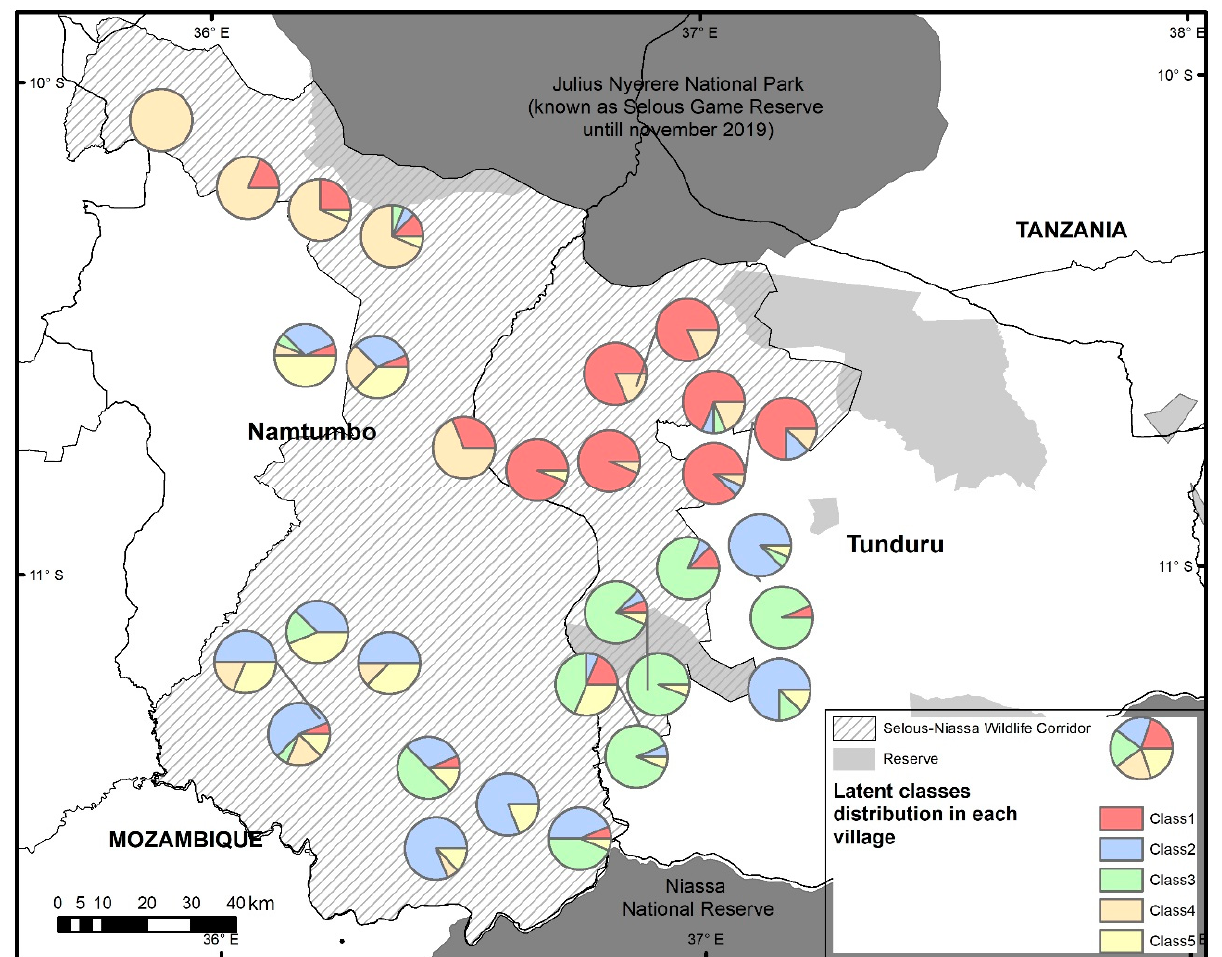
Figure 6. Latent classes’ distribution by village in the Selous-Niassa Wildlife Corridor. Class 1: Affected and cooperative; Class 2: Not affected and cooperation in small groups; Class 3: Not affected and communal; Class 4: Affected and individualist; Class 5: Not affected, whose family, friends, or neighbors have been affected and individualist.